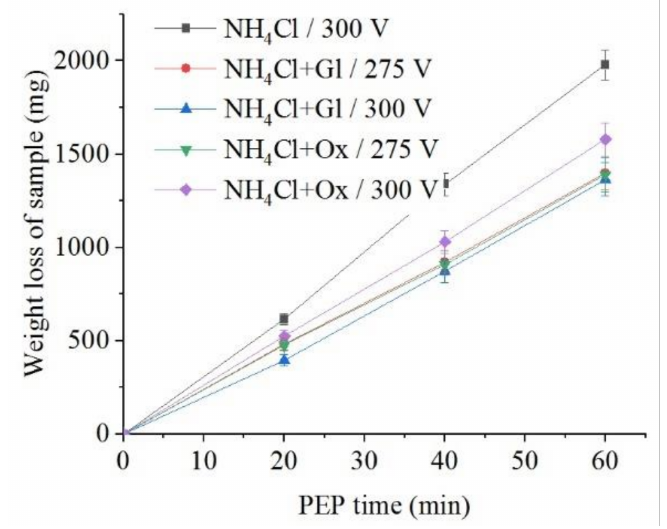
Figure 10. Dependence of the weight loss of the nitrided samples on the PEP duration in ammonium chloride (3%) solution at a temperature of 80 ◦ C without or with glycerol or oxalic acid additions (5% each) at different voltages under forced electrolyte